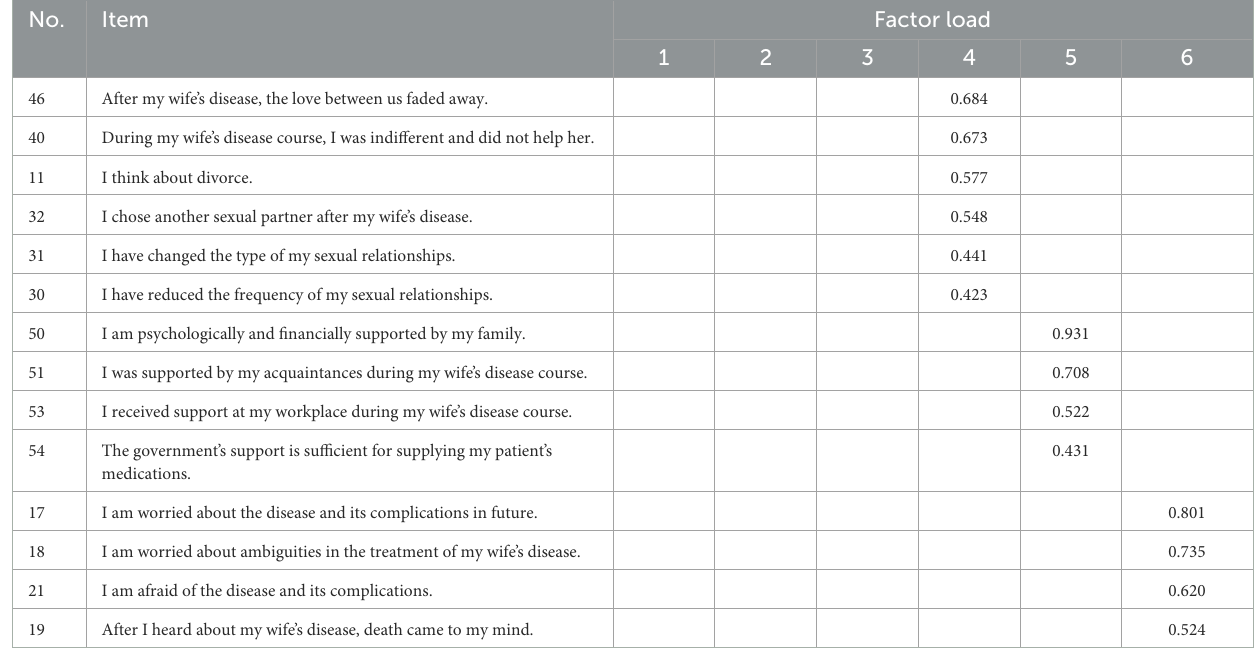
TABLE 4 Investigation of reliability; the results of the split-half and internal consistency tests.